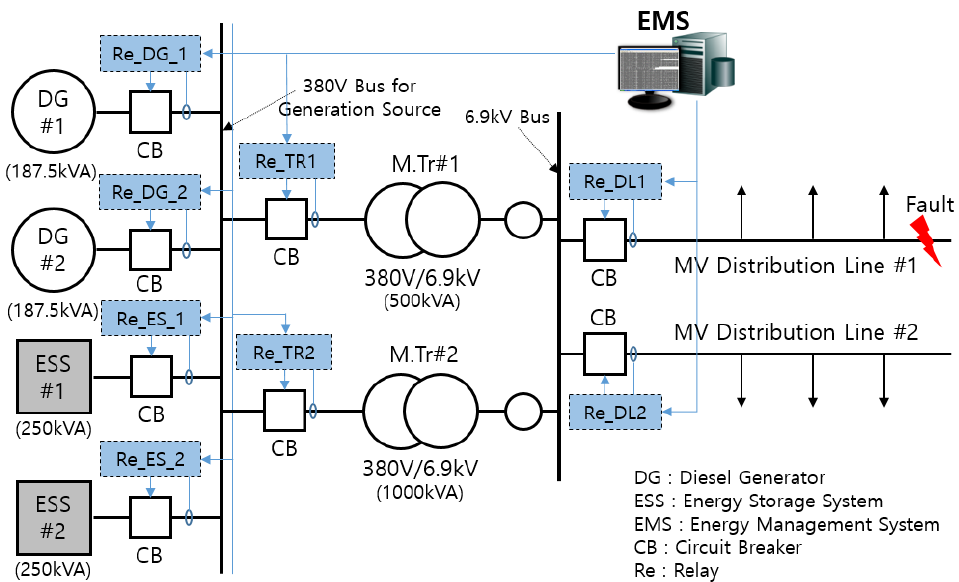
Figure 7. Single line diagram for adaptive protection scheme design of isolated microgrid. Table 2. Parallel operation combination of diesel generators and ESSs.